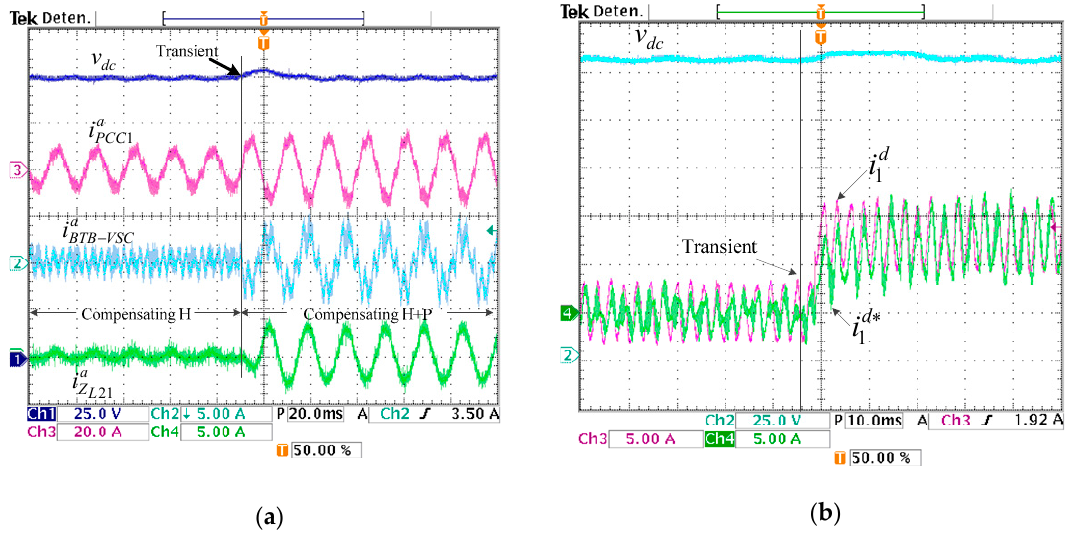
Figure 16. Test results for current harmonic and active power regulation: ( a ) Ch1, DC bus voltage; Ch2, current injected with the BTB-VSC; Ch3, current measured at the PCC1; Ch4, current for the load Z L 21 . Vertical sensitivities: Ch1, 25 V / div; Ch3, 20 A / div, Ch2 and Ch4, 5 A / div. Horizontal sensitivity: 20 ms / div. ( b ) Ch2, DC bus voltage; Ch3 and Ch4, d and q current waveforms. Vertical sensitivities: Ch2, 25 V / div, Ch3 and Ch5 5, A / div. Horizontal sensitivity: 10 ms / div.